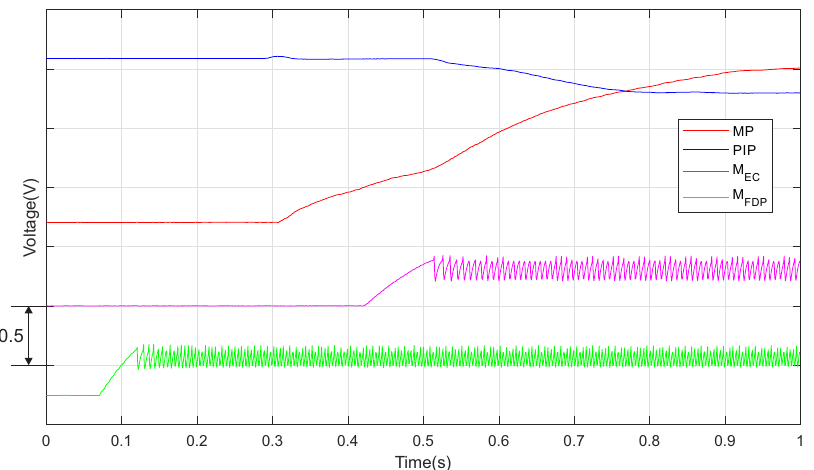
Figure 8. The activity of the motor neurons that drives the actuators EC and FDP together with the output of the